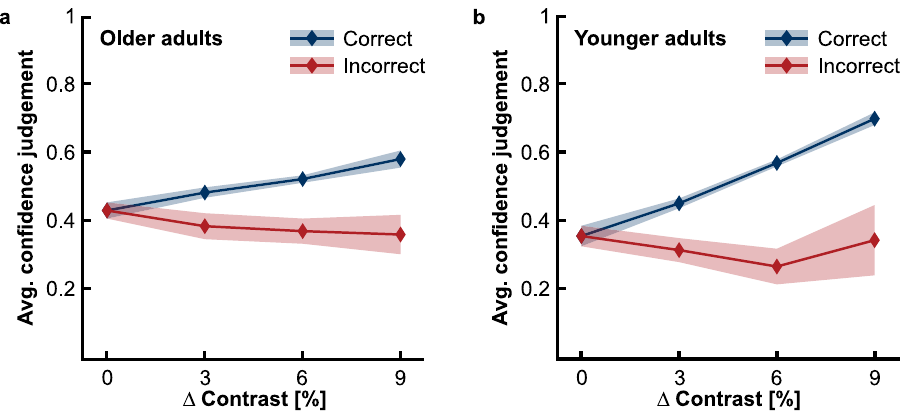
Figure 2. Average confidence judgements for perceptual decisions at different task difficulty levels, plotted separately for correct and incorrect decisions. ( a ) Data for older adults. ( b ) Data for younger adults. Task difficulty level is given as absolute contrast difference between the standard and test patches; task difficulty decreases with difference. Confidence judgements were coded as 1 for chosen and as 0 for not chosen. Please note that confidence judgements were made between two perceptual tasks in a trial. The probability of choosing a decision as confident depends on the difficulty of the other task. We collapsed confidence judgements across the different difficulties. The correctness label for perceptual decisions on patch pairs with zero contrast difference is arbitrary. Shaded areas give 95% confidence